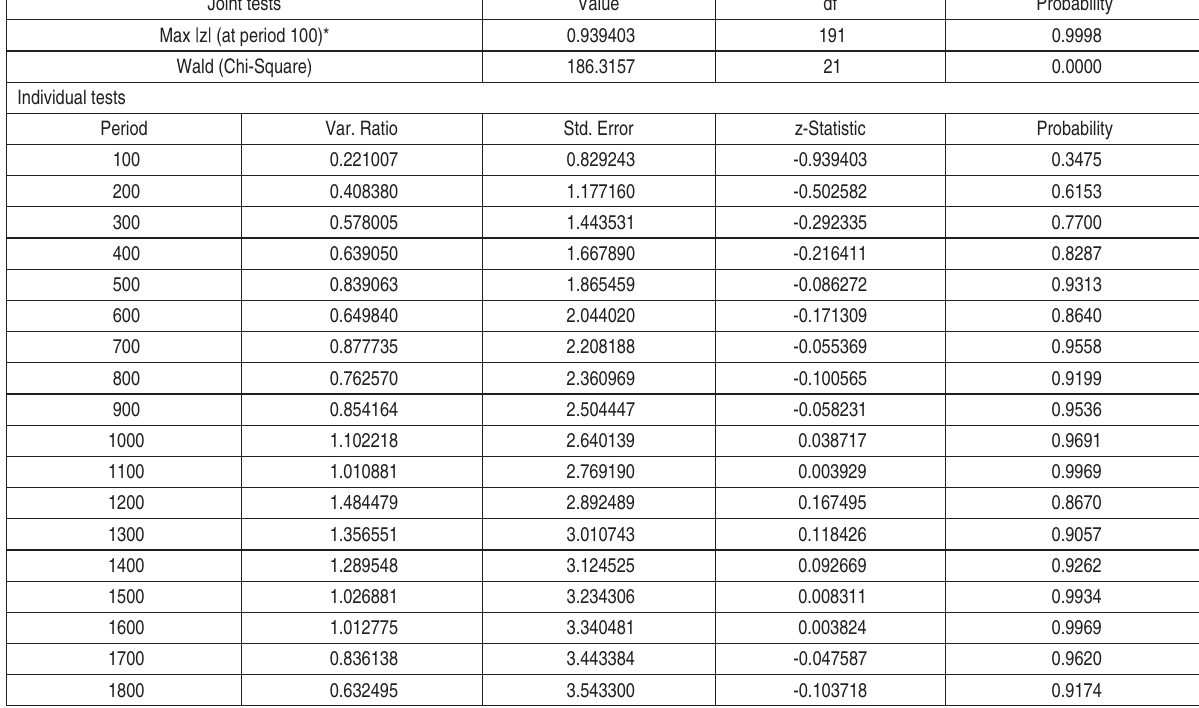
Table 5. Results of the variance ratio test DSE ALSI daily